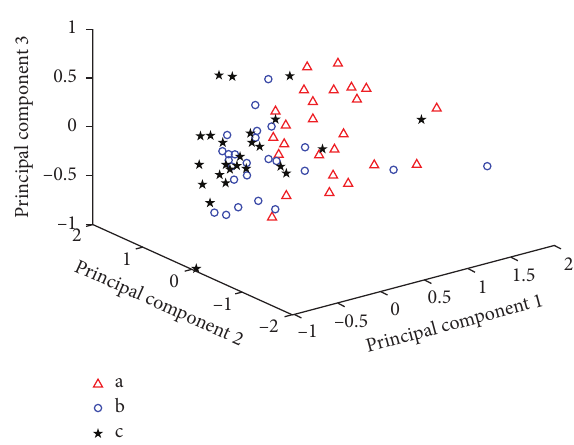
Figure 3: Three-dimensional scatter plot of principal components of cheese products based on their Raman spectra (a, brand XX; b, brand YY; and c, brand